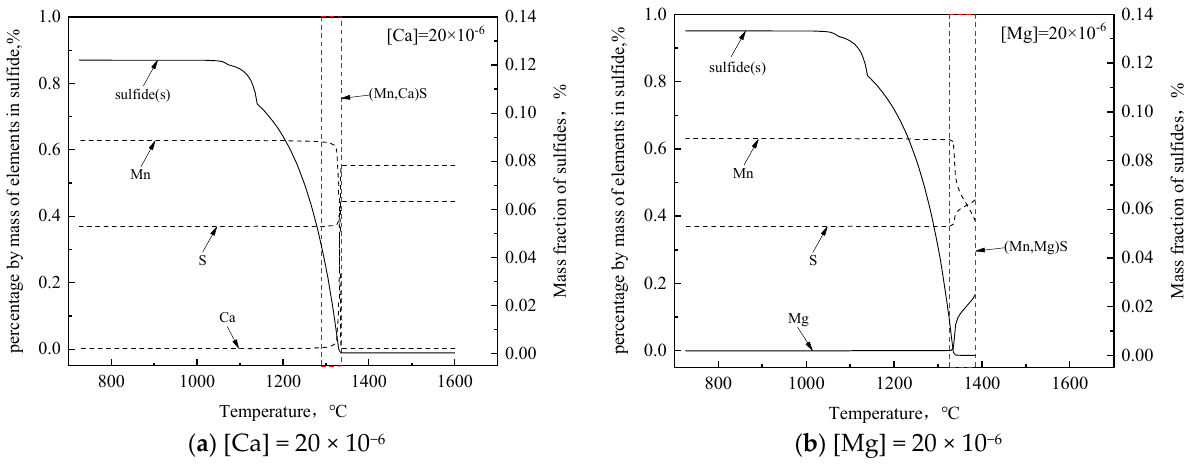
Figure 13. Temperature range for complex sulfide formation when the contents of Ca and Mg are both 20 × 10 − 6 .